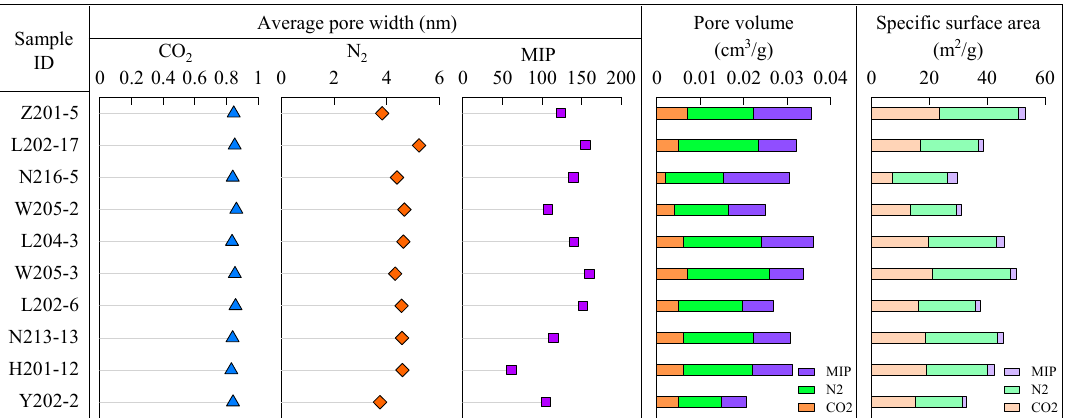
Figure 7. Quantitative analysis of pore structure of Longmaxi shales by high ‐ pressure mercury intrusion porosimetry (HMIP), N 2 and CO 2 adsorption ‐ desorption experiments.